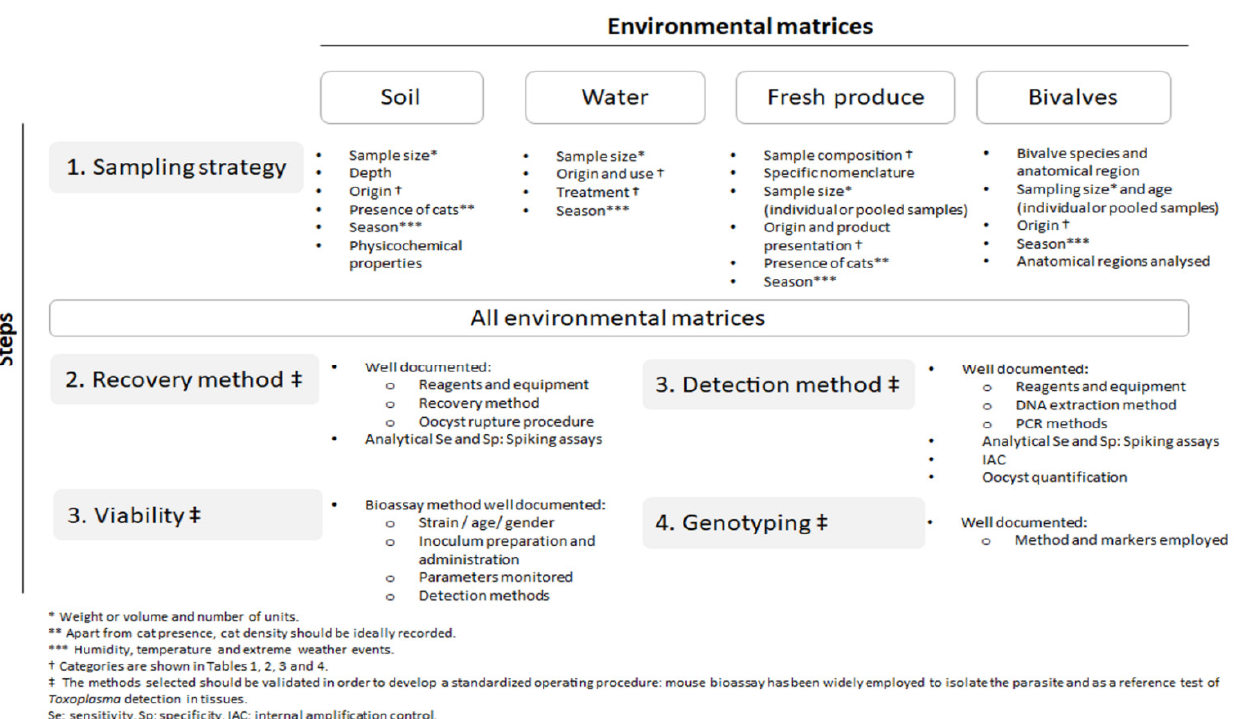
Supplementary Figure S5 (Funnel plots for each matrix) and Supplementary Tables S1–S5: Excel file with the list of papers selected from each database and combination of search terms (Supplementary Table S1) and detailed data extracted from articles on soil (Supplementary Table S2), water